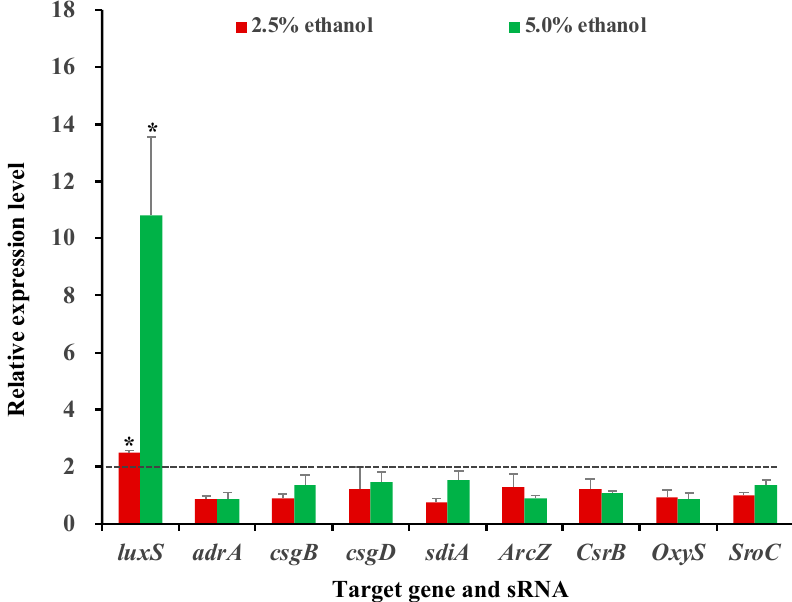
Figure 4. Relative expression levels of selected genes and sRNAs under subinhibitory ethanol concentrations (1/4 MIC, 2.5%; 1/2 MIC, 5.0%). Stars (*) above vertical bars represent a significant difference ( p < 0.05) in gene expression.